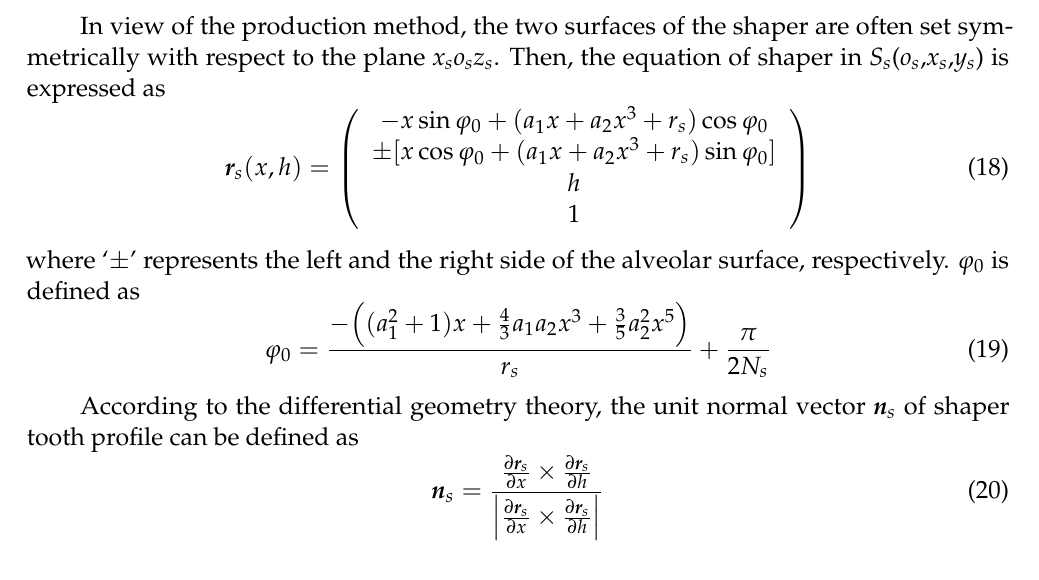
Figure 4. Generation of the face gear.